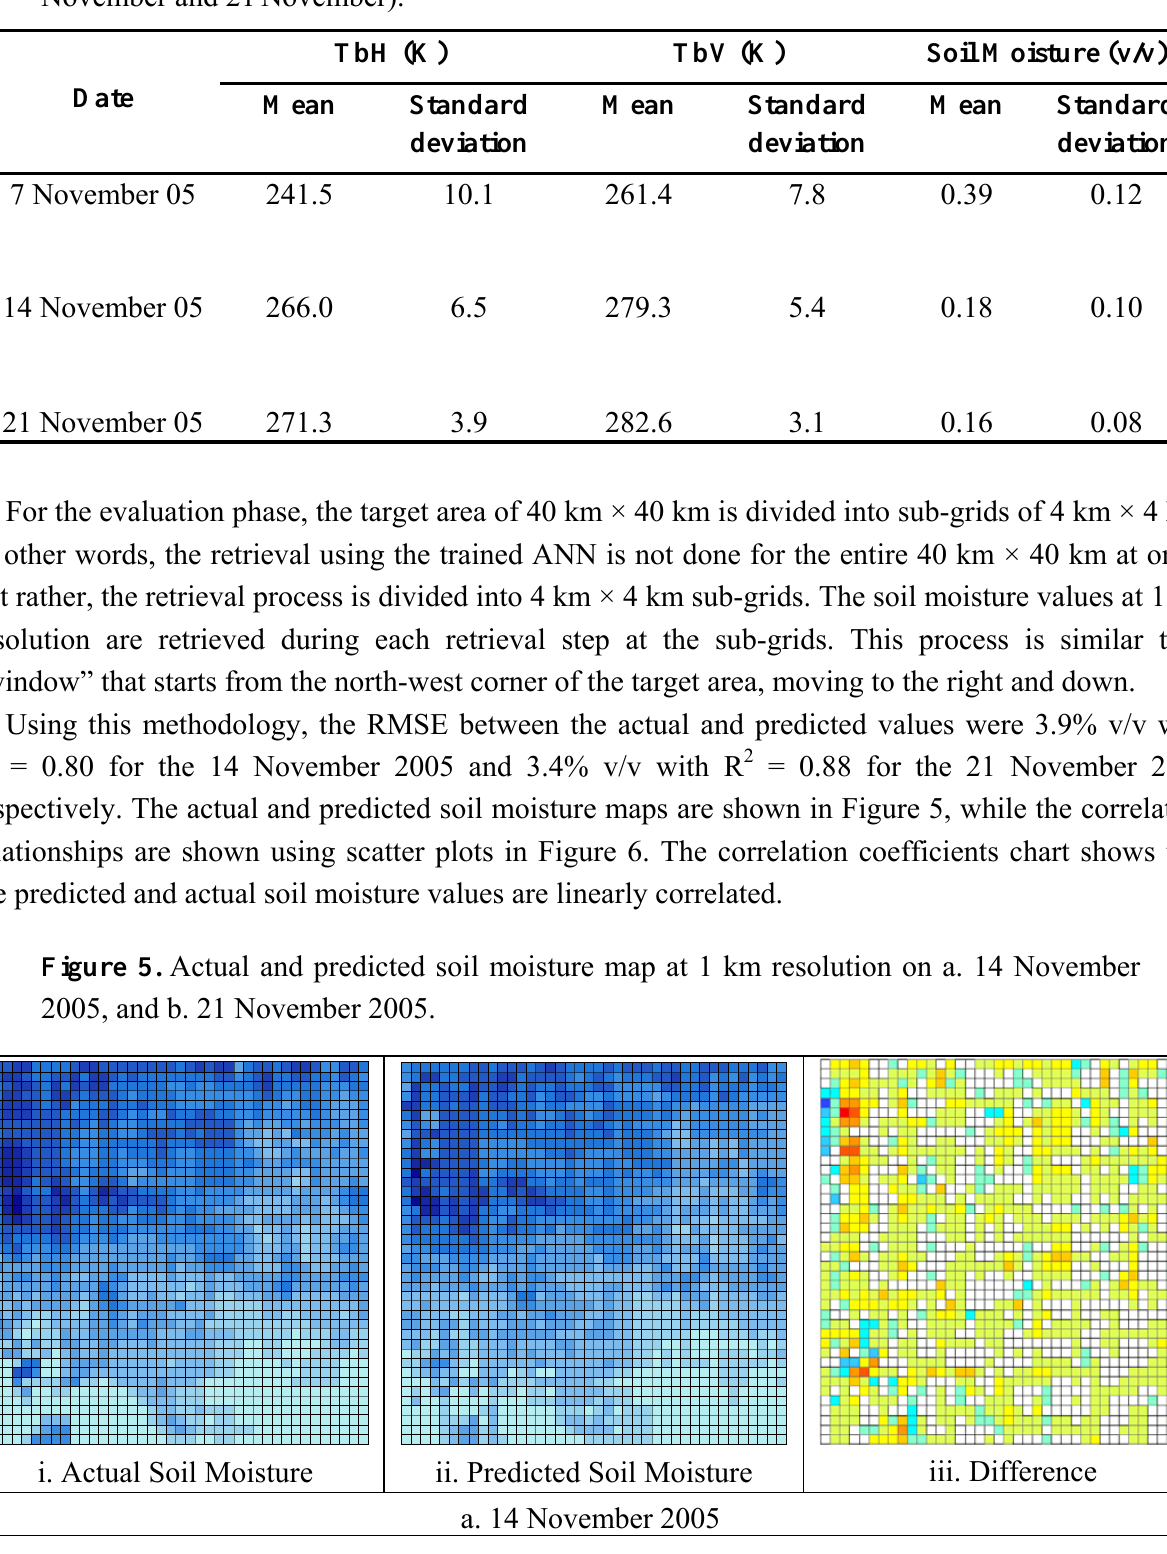
Table 7 . Statistical means and standard deviations for the dual polarized brightness temperature and soil moisture values for training (7 November) and verification (14 November and 21 November).